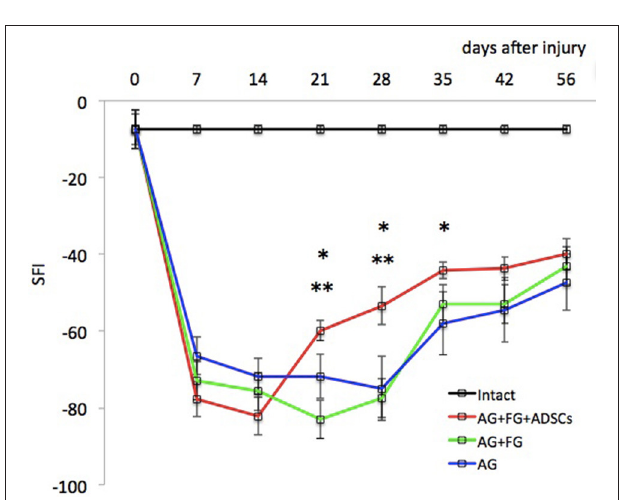
FIGURE 4 | Evaluation of motor function restoration of the hind extremity of rats (Sciatic Functional Index—test). Error bars represent standard error mean. Differences were statistically significant between the groups (*), between groups AG + FG + ADSCs and AG; (**), between groups AG + FG + ADSCs and AG + FG (* , **- P < 0.05, one-way ANOVA, Tukey’s test).